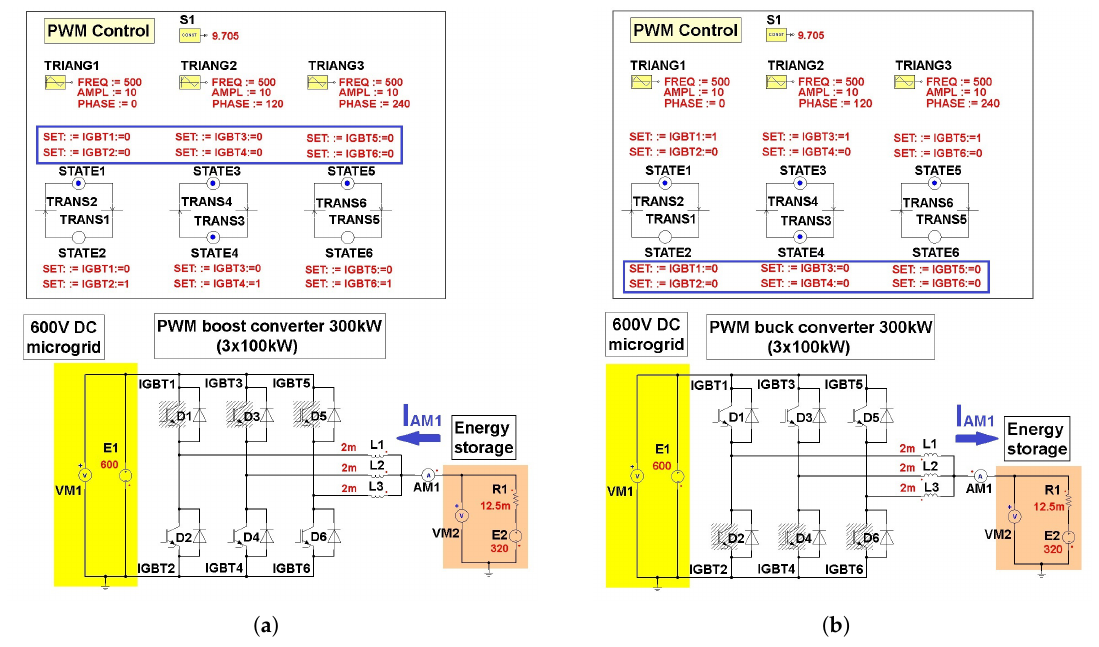
Figure 4. Model of DC/DC converter: ( a ) boost type—energy is transferred from energy storage to DC microgrid, ( b ) buck type—energy is transferred from DC microgrid to energy storage.